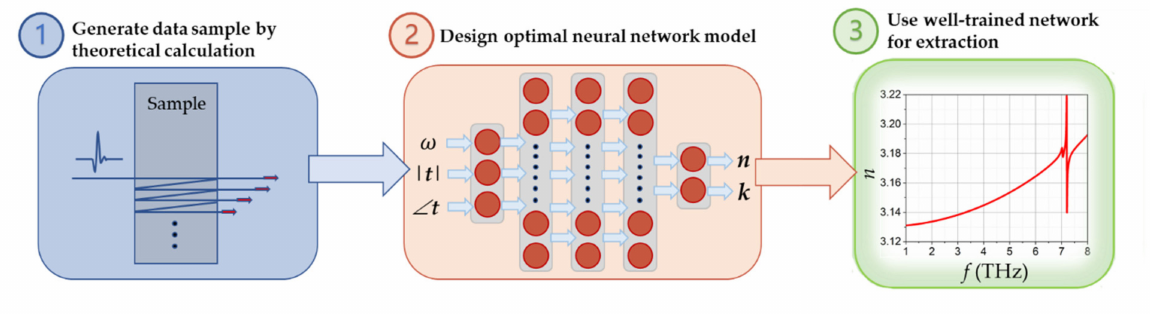
Figure 1. Flow chart of neural network method to extract optical parameters of materials from the transfer